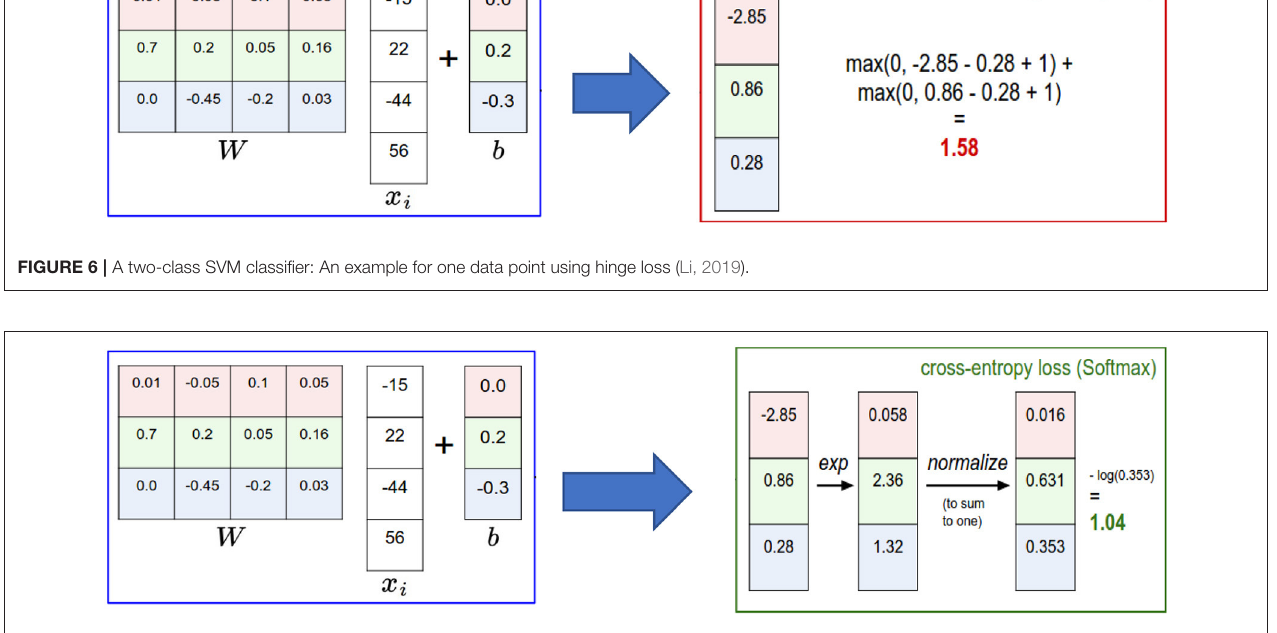
FIGURE 7 | Multiclass SVM classifier: An example for one datapoint using cross entropy loss (Li,